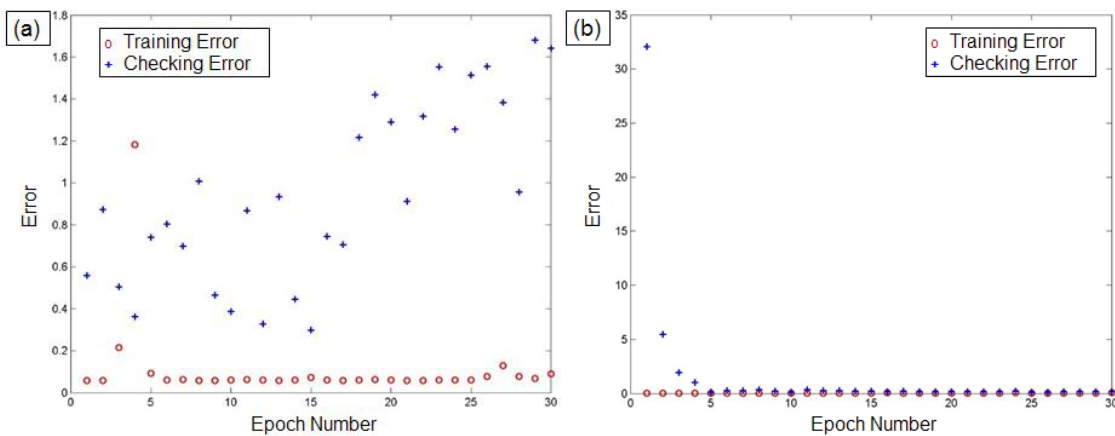
Figure 6. GA convergence plots for ANFIS parameter tuning: ( a ) Ra , ( b ) kw, and ( c ) mh. From the results of GA trained ANFIS, the optimal parameters of the FIS